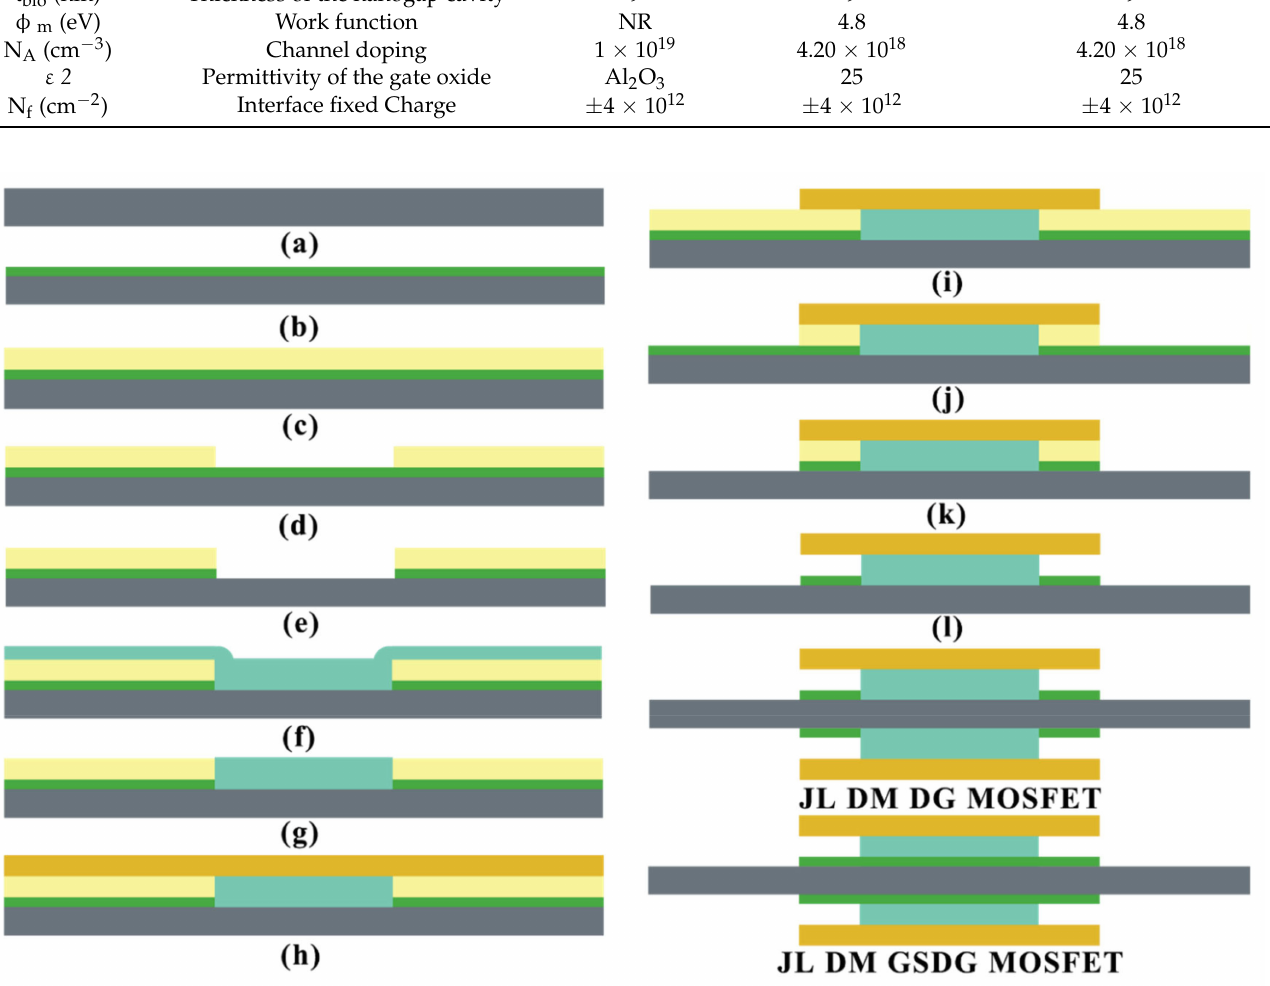
Figure 2. The process flow of the n-type JL-DM-DG-MOSFET and JL-DM-GSDG-MOSFET ( a – l